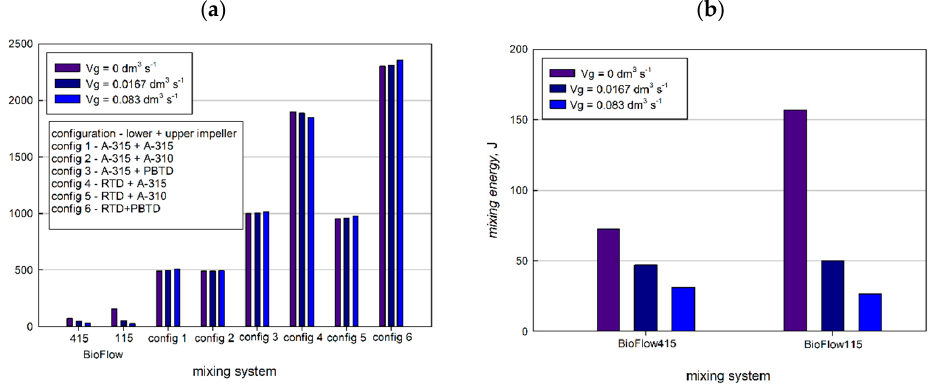
Figure 11. Comparison of mixing energy for different mixing systems ( a ) and mixing energy for tested BioFlow systems at n = 8.33 s − 1 (b).